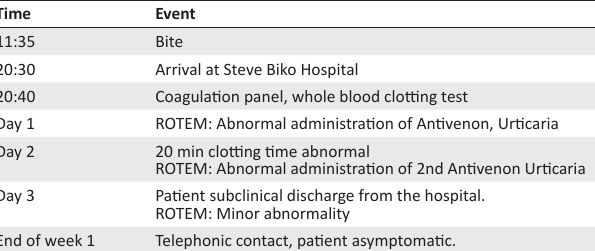
TABLE 1-A1: Sequence of events from the snake bite to the time patient was discharged from the